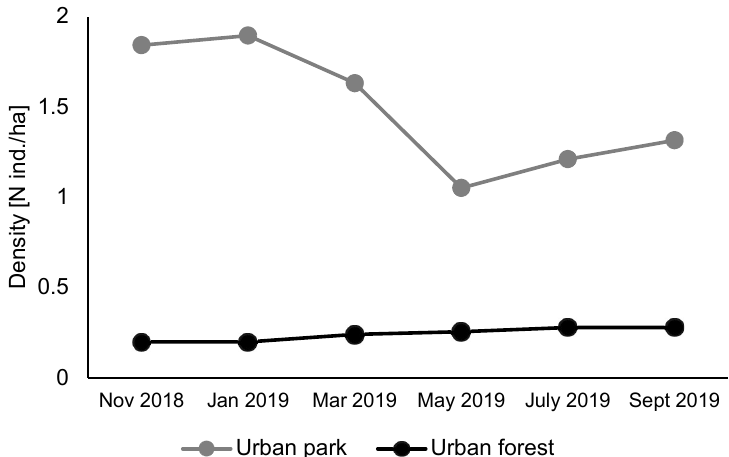
Figure 2. Density of the two studied populations of red squirrels in Warsaw: urban park and urban forest, assessed on the basis of live-trapping and MNA estimates.